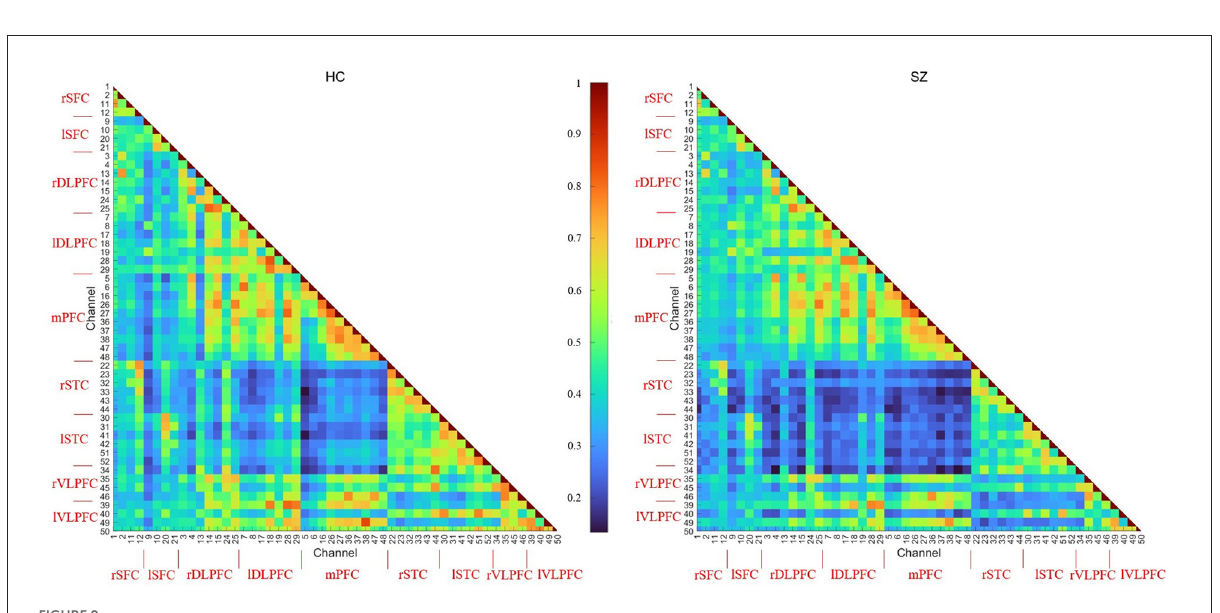
FIGURE9 FC feature of 52 channels averaged for the HCs and SZs during the VFT,